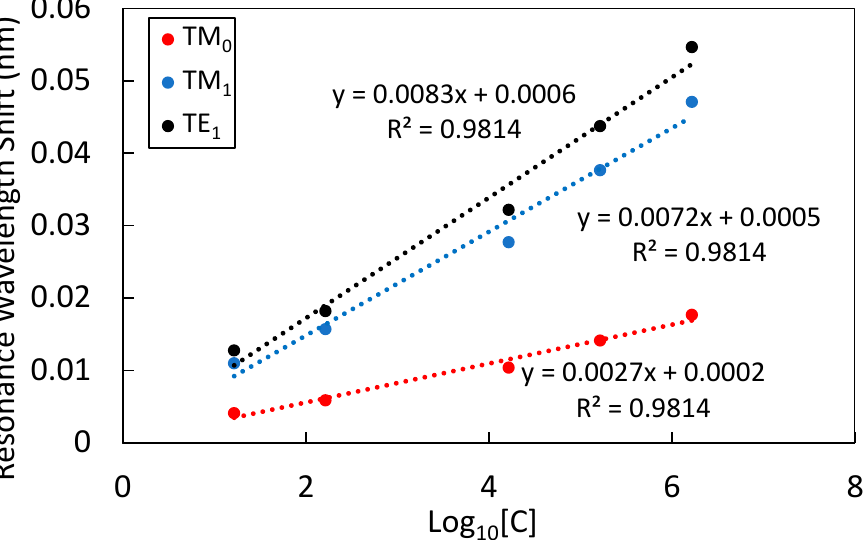
Figure 10. Scaled GMR sensor response from a series dilution of yeast cells in suspension with PBS. This data is based on our past work published in Abdallah et al. [4].